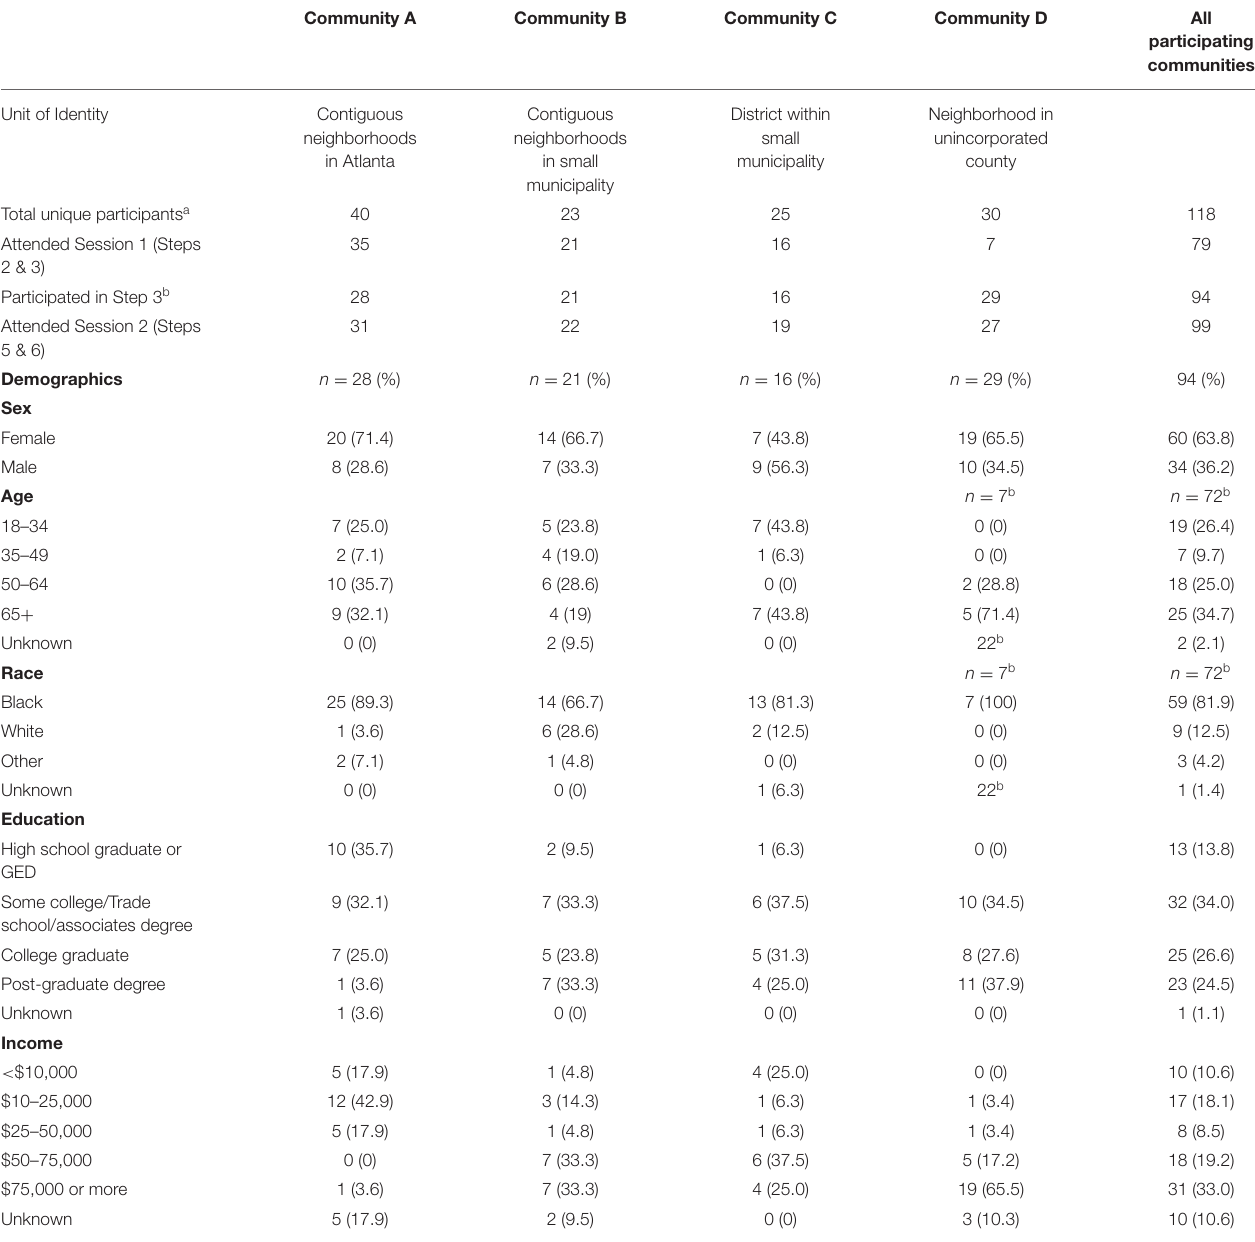
TABLE 3 | Demographics of roadshow workshop participants by community. Community A Community B Community C Community D